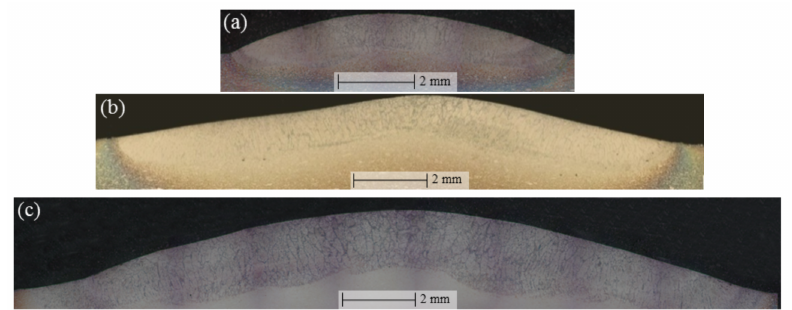
Figure 3. Cross section of different heat inputs: ( a ) low heat input (bead width 8.8 mm); ( b ) medium